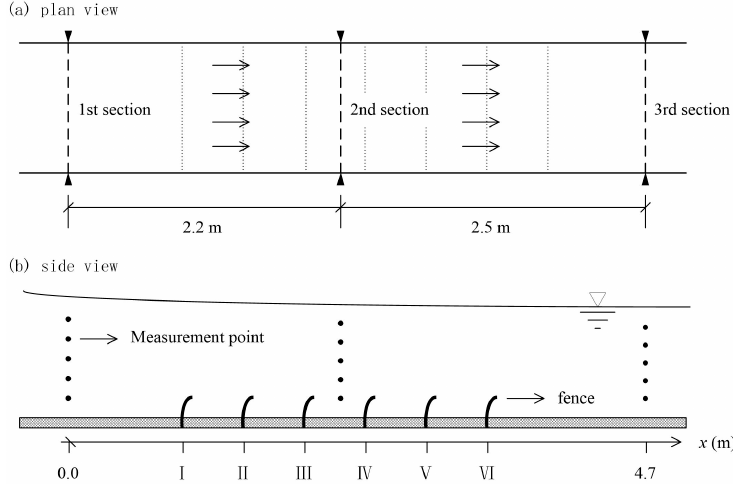
Figure 1. Schematic diagram of experimental setup. ( a ) plan view; ( b ) side view.